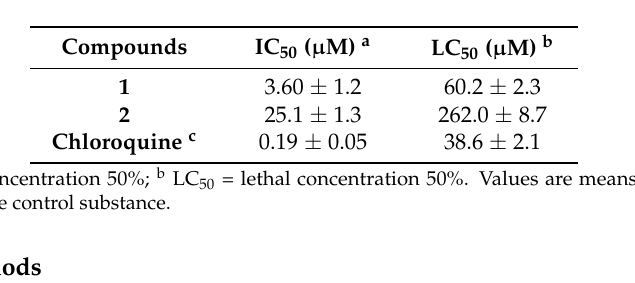
Table 2. In vitro antiplasmodial and Larvicidal activities of compounds 1 – 2 .